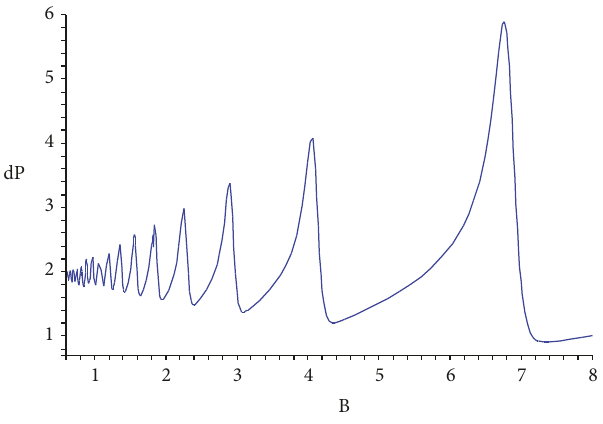
Figure 1: Microwave-radiation absorption oscillations ( 𝑑𝑃/𝑑𝐻 ) in InSb at the temperature T = 3K and electromagnetic field strength 𝐸 = 10 3 (𝑉/𝑠𝑚) , with the help of formula (10) being calculated. 𝐸